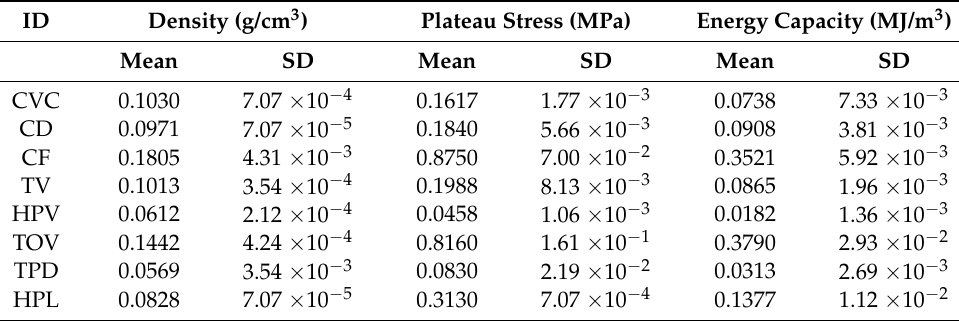
Table 7. Mean values and standard deviation for ABS lattice